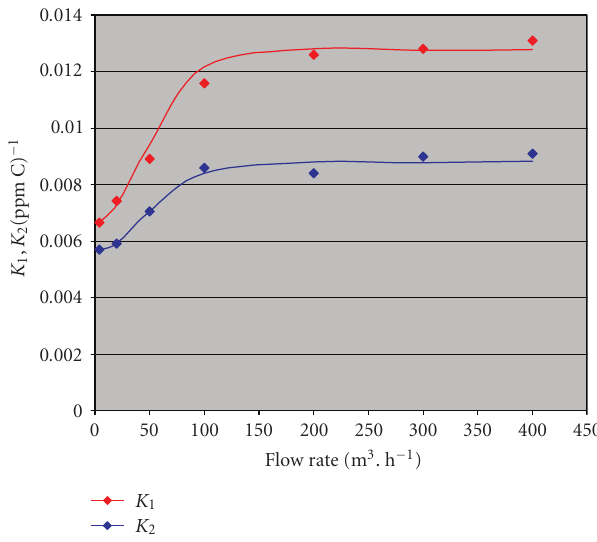
Figure 3: Variation of K 1 and K 2 parameters, expressed in (ppmC) − 1 (see kinetic modeling in Experimental), as a function of flow rate (m 3 · h − 1 ), for photomineralization of methane in air, and experiments carried out at a fixed irradiance corresponding to 0.30 W · cm − 1 . The mean values of k 1 and k 2 parameters, re- sulting from modeling of these same experiments, were sensi- bly constant ( k 1 = 0 . 225 ± 0 . 005 ppmC · min − 1 ; k 2 = 0 . 578 ± 0 . 007 ppmC · min − 1 ), independently on values of flow rates. Photo- catalytic membranes used in the relative experiments did not con- tain any photopromoting agent.